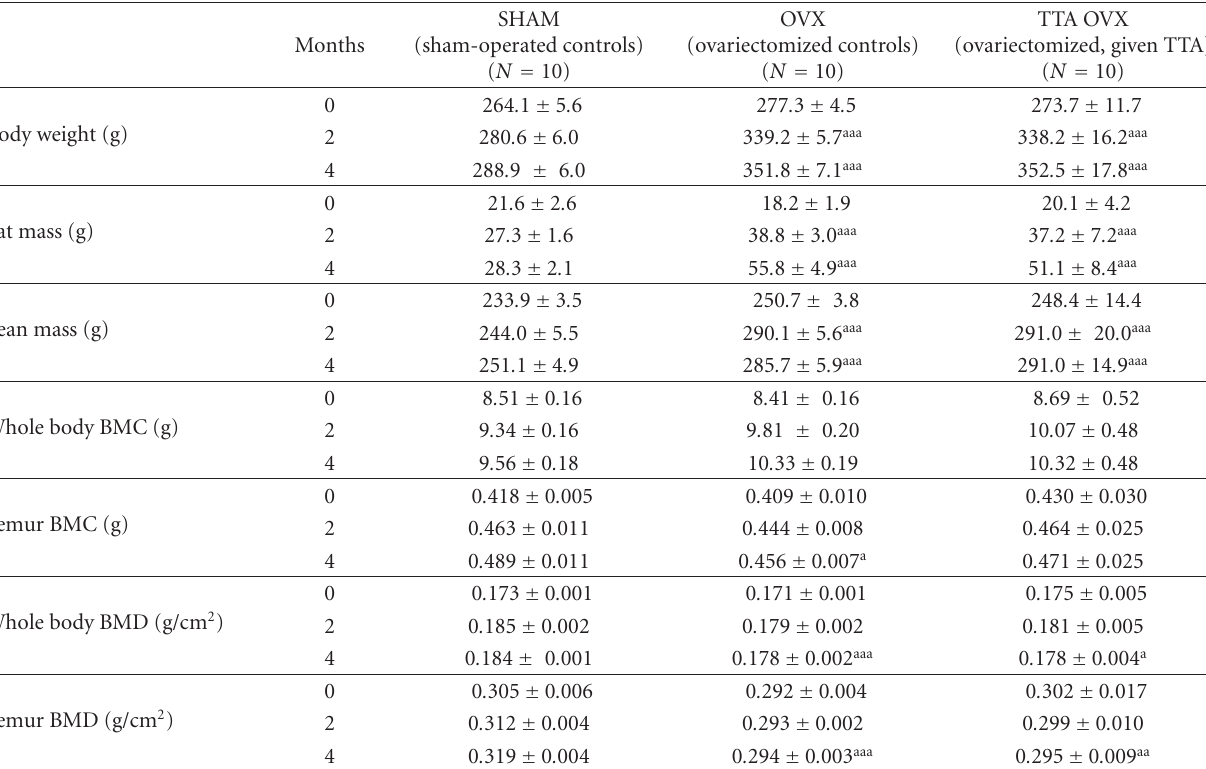
Table 4: Body weight, fat and lean mass, femoral and whole body bone mineral content (BMC), and bone mineral density (BMD) in mean values ± SEM in sham controls, ovariectomized controls, and ovariectomized rats fed TTA, at baseline, and after two and four months (Study